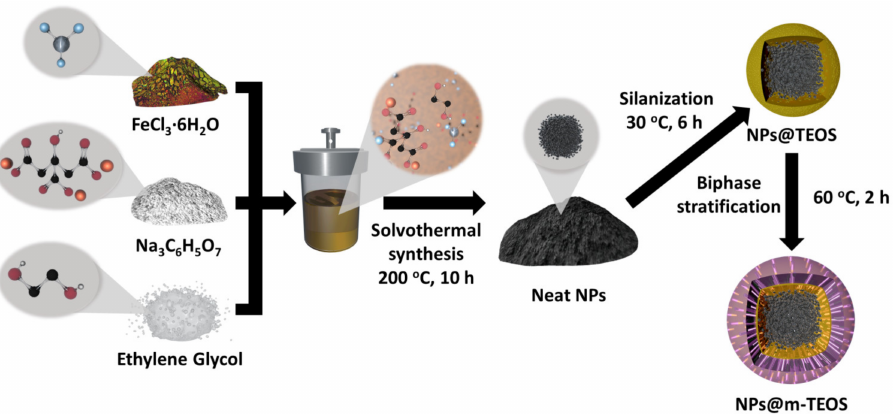
Figure 10. Reaction scheme comprising solvothermal synthesis, silanization and biphase